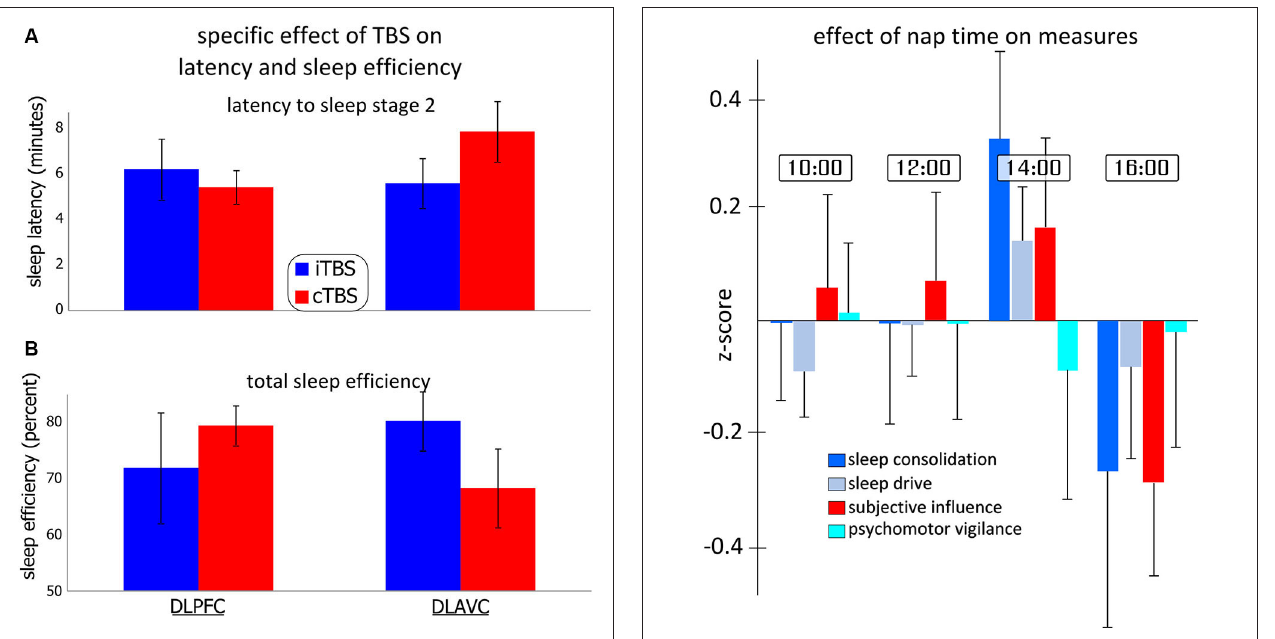
FIGURE 4 | Differences in sleep measures for each nap time . Each measure represents the aggregated z -scores from various measurements during the day of testing independent of the TBS-type and location of stimulation. As can be seen in the figure, and supported by statistical analysis, the largest differences in measures occur between naps 3 and 4. Error bars indicate the standard error for each measure and nap time